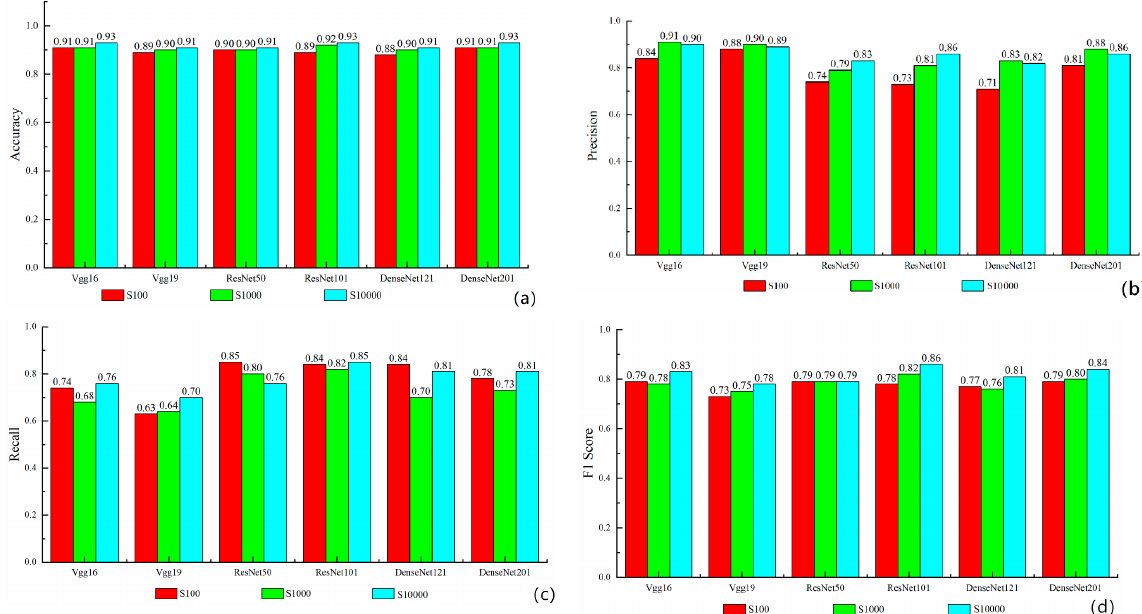
Figure 8. Statistical performance of scene-oriented models: ( a ) accuracy; ( b ) precision; ( c ) recall; ( d ) F1 score.